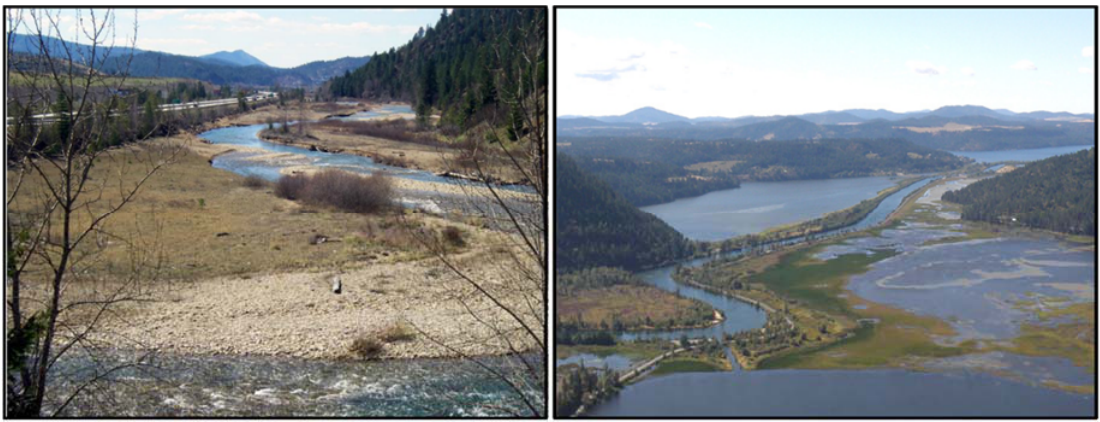
Figure 2. Images of the South Fork of the Coeur d’Alene River near Kellogg, Idaho, in the upper basin ( left ) and the main stem of the Coeur d’Alene River near Harrison in the lower basin ( right ) (courtesy of the U.S. Geological Survey).